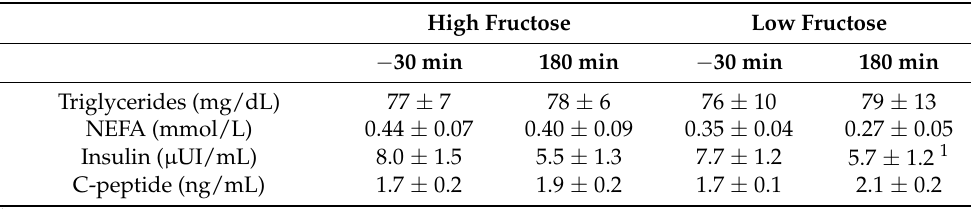
Table 1. Plasma metabolites measured 30 min before and 180 min after a meal containing 50 g of sugar with 55/45 fructose/glucose (High Fructose) and 5/95 fructose/glucose (Low